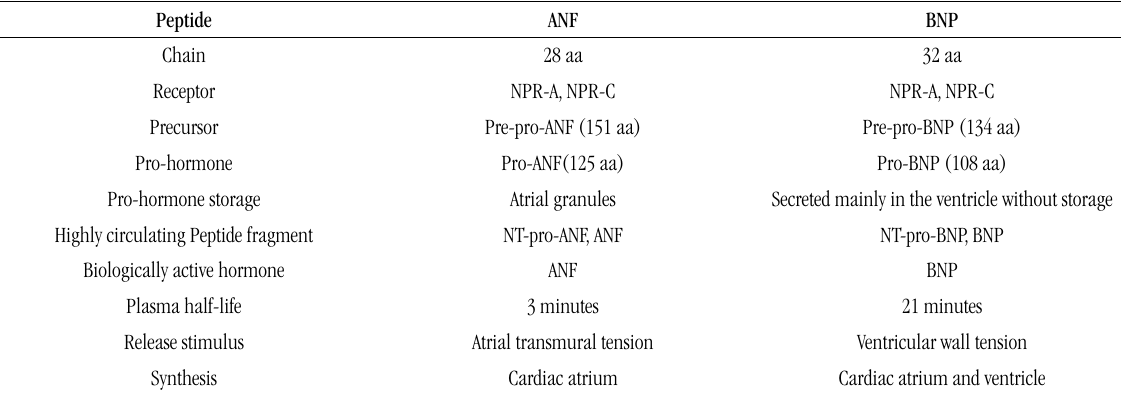
tABLE 1 – Biochemical and physiological characteristics of natriuretic peptides